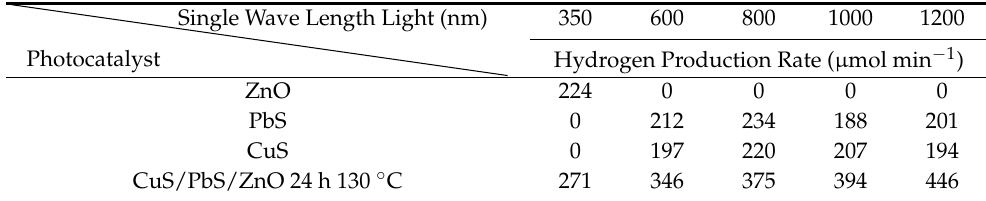
Table 2. Evaluation of hydrogen production rate by single and heterojunction photocatalysts at monochromatic light.